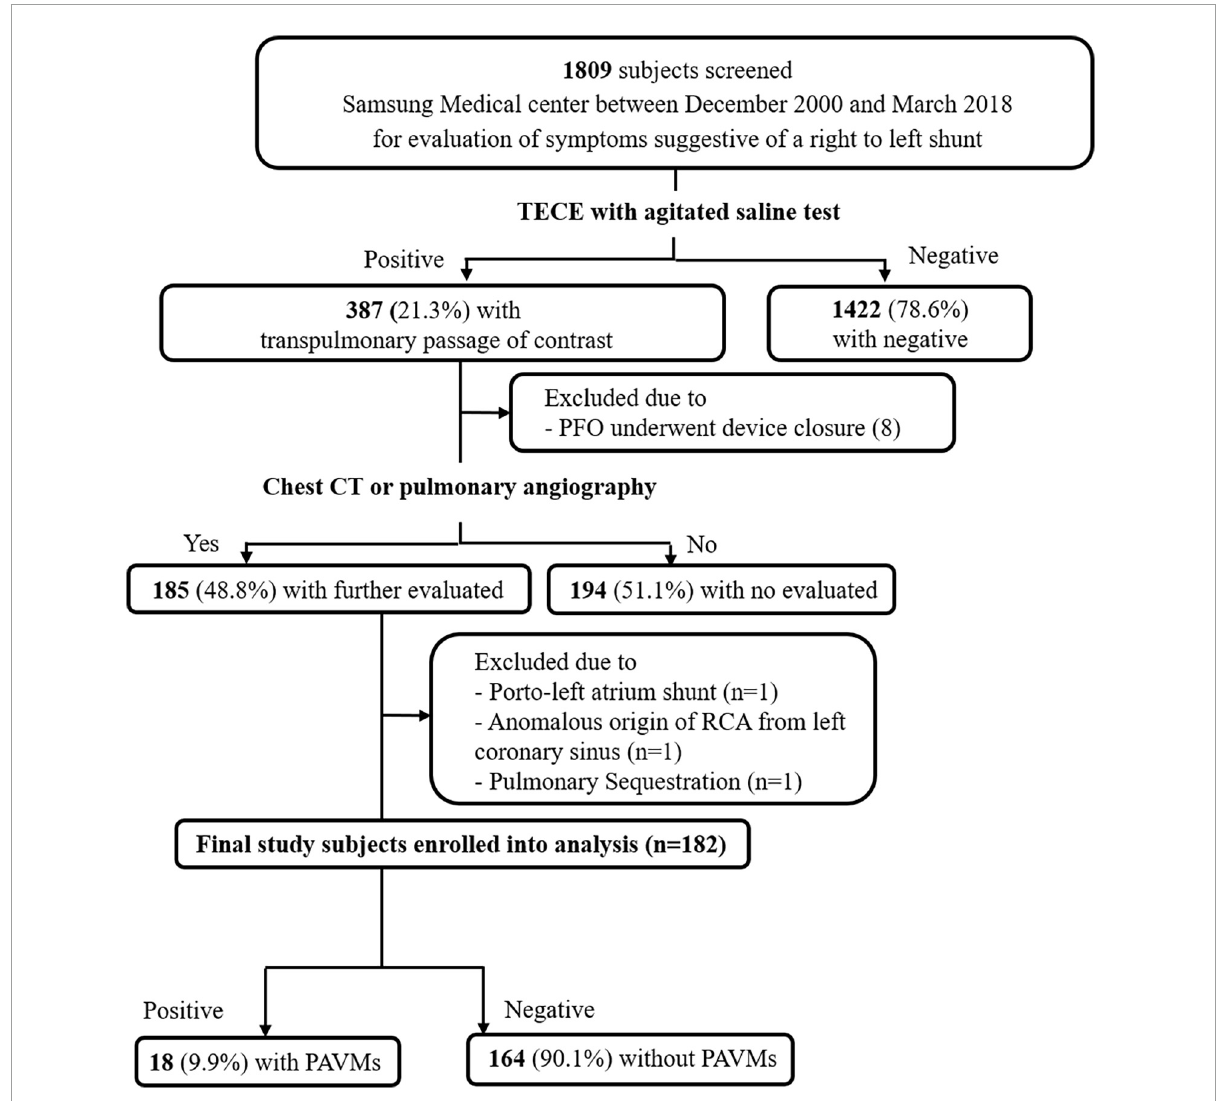
FIGURE1 A schematic diagram of study patient selection. TECE, transesophageal contrast echocardiography; PFO, patent foramen ovale; CT, computed tomography; RCA, right coronary artery; PAVM, pulmonary arteriovenous malformation.